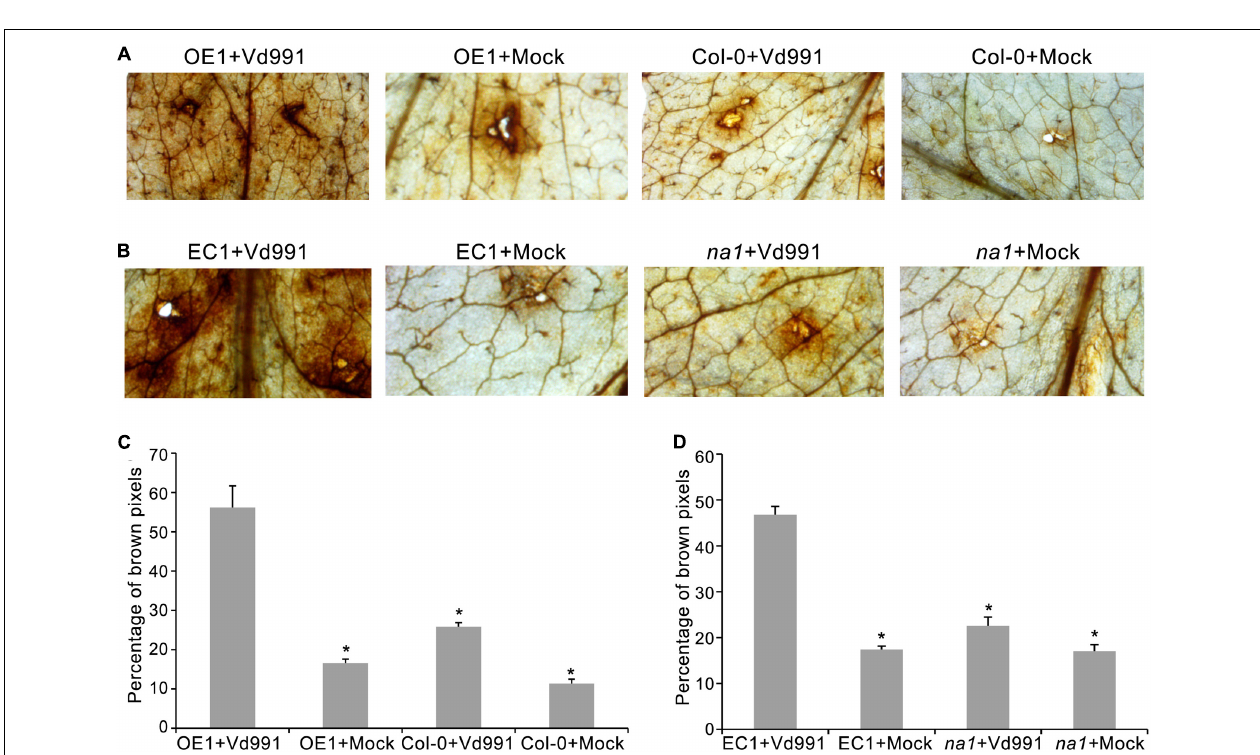
FIGURE 4 | Cotton GbaNA1 modulates ROS accumulation in Arabidopsis thaliana . (A) The ROS-inducing activities of GbaNA1 transgenic A. thaliana and wide type (Col-0) plants inoculated with V. dahliae, strain Vd991. ROS accumulation was assessed in GbaNA1 transgenic A. thaliana and wide type (Col-0) leaves from 3-week-old plants 12 h after infiltration with a 50 µ L suspension (5 × 106 conidia/mL) of V. dahliae , strain Vd991. Sterile water treatments were used as controls (Mock). (B) Detection of ROS-inducing activities of A. thaliana na1 mutants and na1 mutants after introduction of GbaNA1 . (C) The percent of brown pixels of GbaNA1 transgenic A. thaliana (OE1) and wild-type (Col-0) plants inoculated with V. dahliae strain Vd991. ROS accumulation level was assessed in GbaNA1 transgenic A. thaliana and wide type (Col-0) leaves from 3-week-old plants 12 h after infiltration with a 50 µ L conidial suspension (5 × 10 6 conidia/mL) of V. dahliae , strain Vd991 followed by staining with DAB. Sterile water treatments were used as controls (Mock). (D) Detection of ROS-inducing level of A. thaliana na1 mutants and na1 mutants after the introduction of GbaNA1 . EC1, the transgenic lines of overexpression GbaNA1 in na1 mutant.